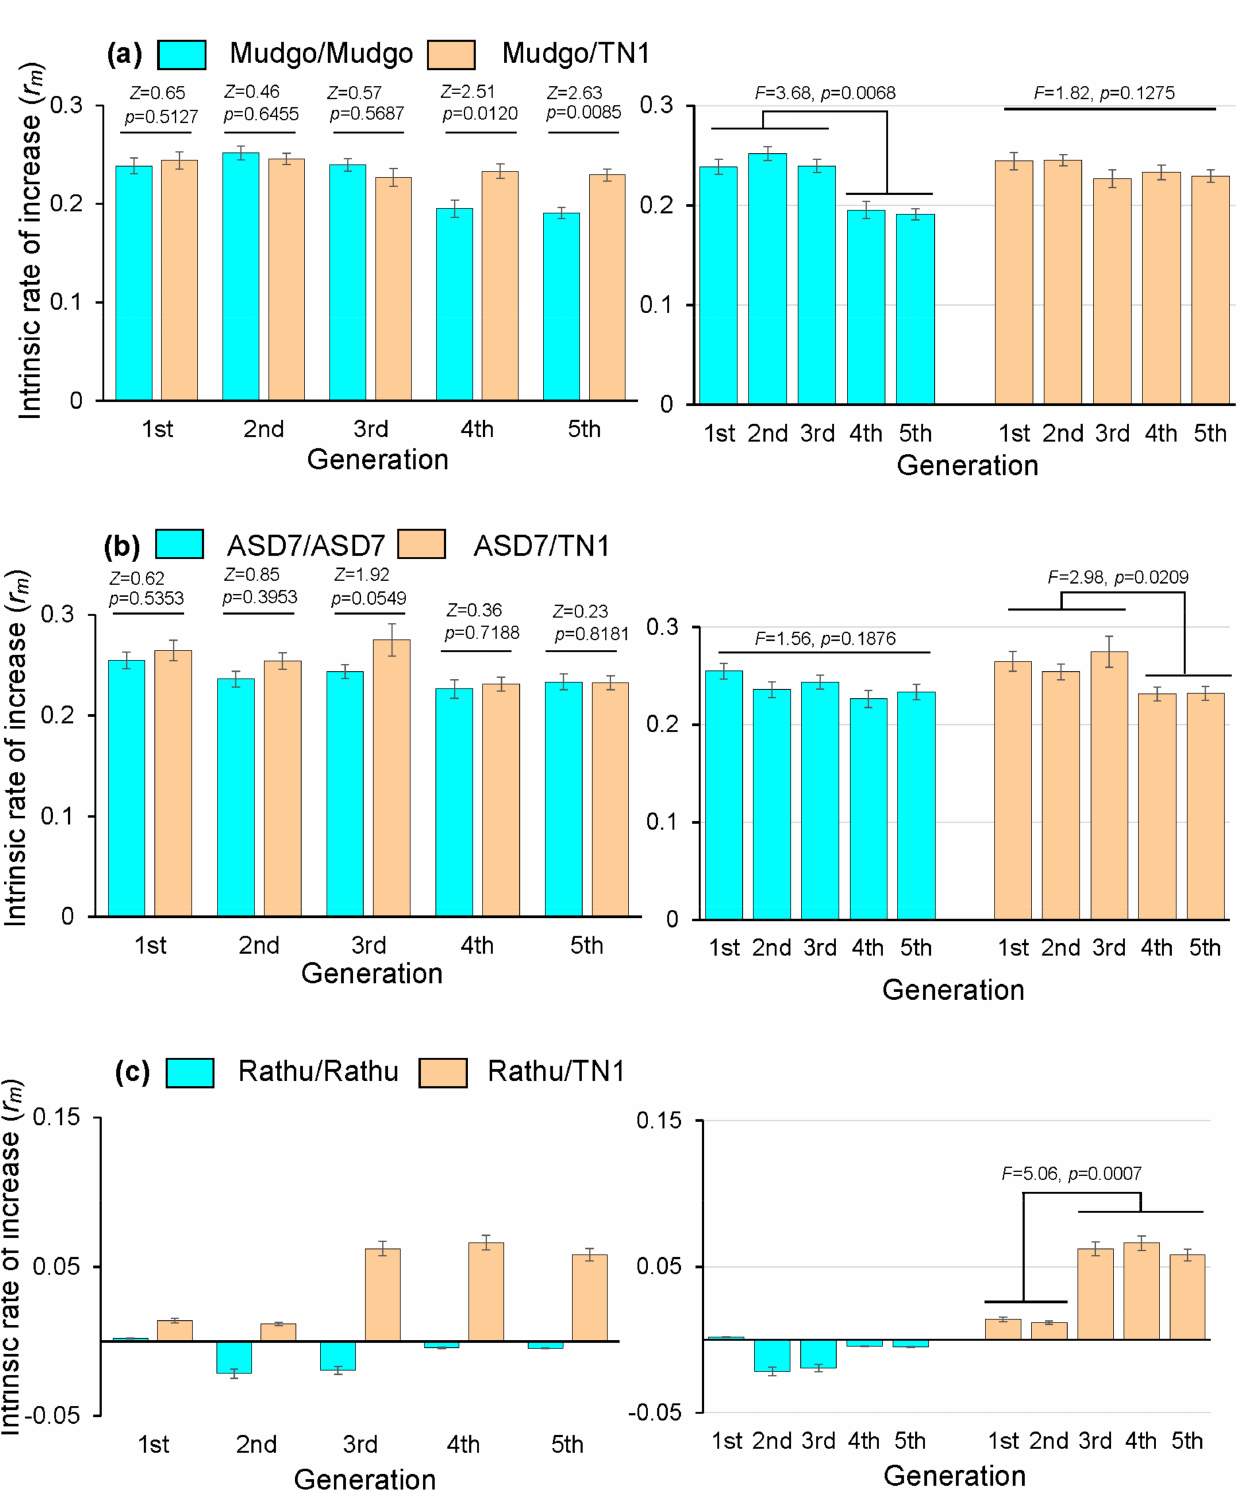
Figure 1. Effects of rice varieties on the intrinsic rate of increase ( r m ) of Nilaparvata lugens over multiple generations under resistant/resistant and resistant/susceptible alternate rearing. ( a ) Mudgo/Mudgo and Mudgo/TN1 alternate rearing; ( b ) ASD7/ASD7 and ASD7/TN1 alternate rearing; ( c ) Rathu Heenati/Rathu Heenati and Rathu Heenati/TN1 alternate rearing. Data are the mean jackknife pseudo-values ± SEM ( n = 40). Statistics and p -values were calculated using a two-tailed Z-test (two-level) or ANOVA